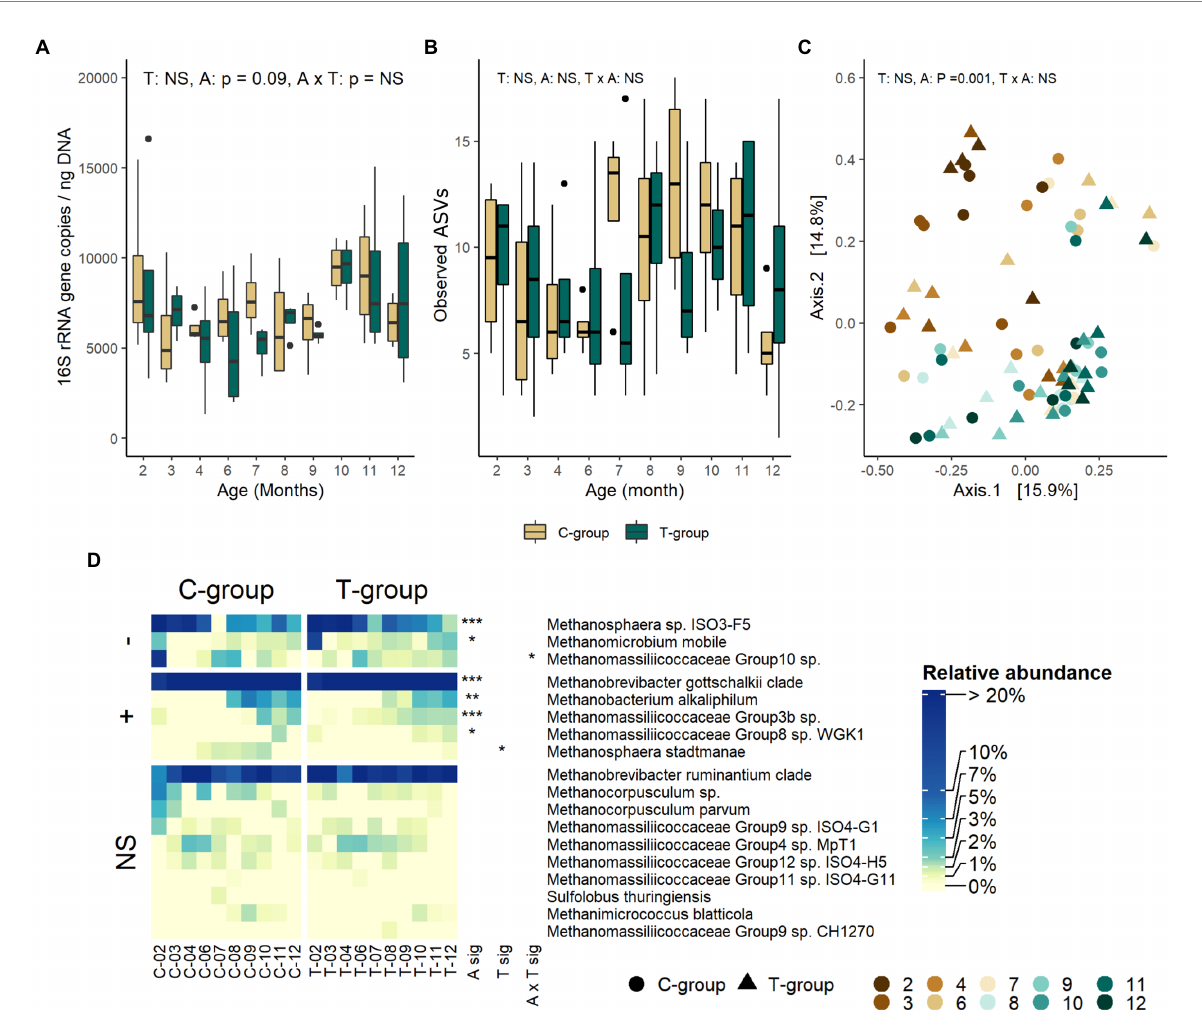
FIGURE 1 The rumen archaeal community in treatment (T-group) and control (C-group) heifers at 2–12 months of age. (A) The rumen archaea 16S rRNA gene copy numbers, (B) the number of observed ASVs, (C) principal coordinate analysis visualization of Bray-Curtis community distances, and (D) the relative abundances of rumen archaea species. Only taxa with statistical significances are shown. The taxa are grouped by increasing (+) or decreasing ( − ) trend with time, or no significant effects (NS). Statistical significance of Treatment (T-sig), Age (A-sig), and Treatment × Age interaction (T × A sig): p < 0.05: *, p < 0.01: **, p < 0.001: